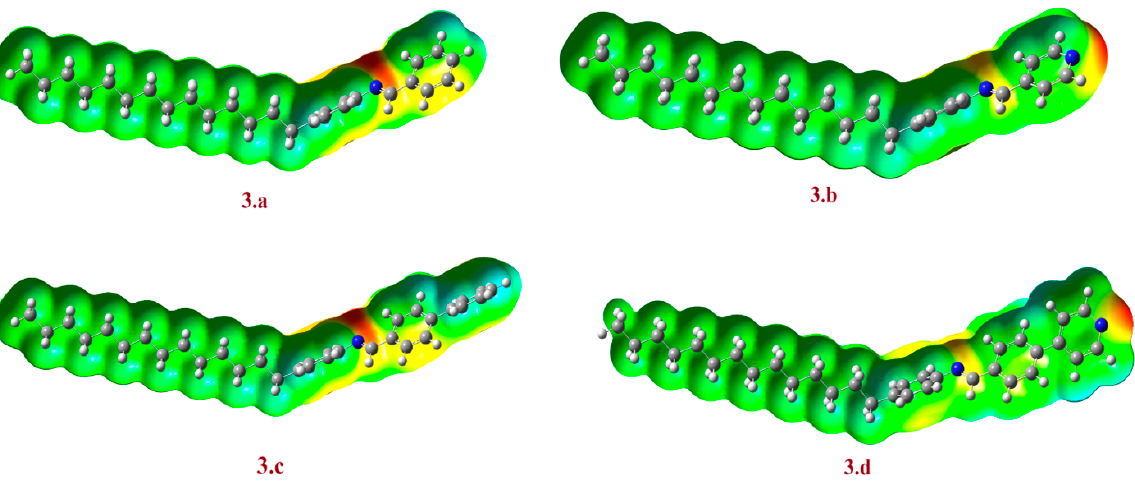
Figure 6. Molecular electrostatic potentials (MEP) for the prepared compounds 3.a , 3.b , 3.e and 3.h.